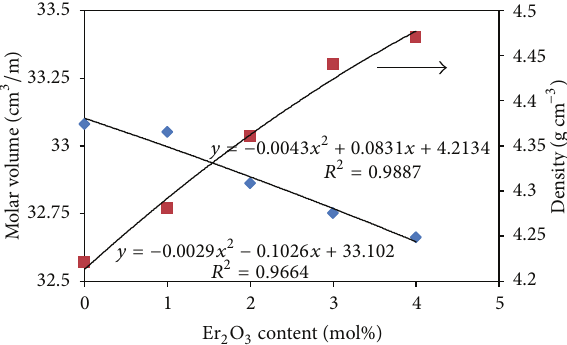
Figure 3: The variation of density and molar volume of EZT glass